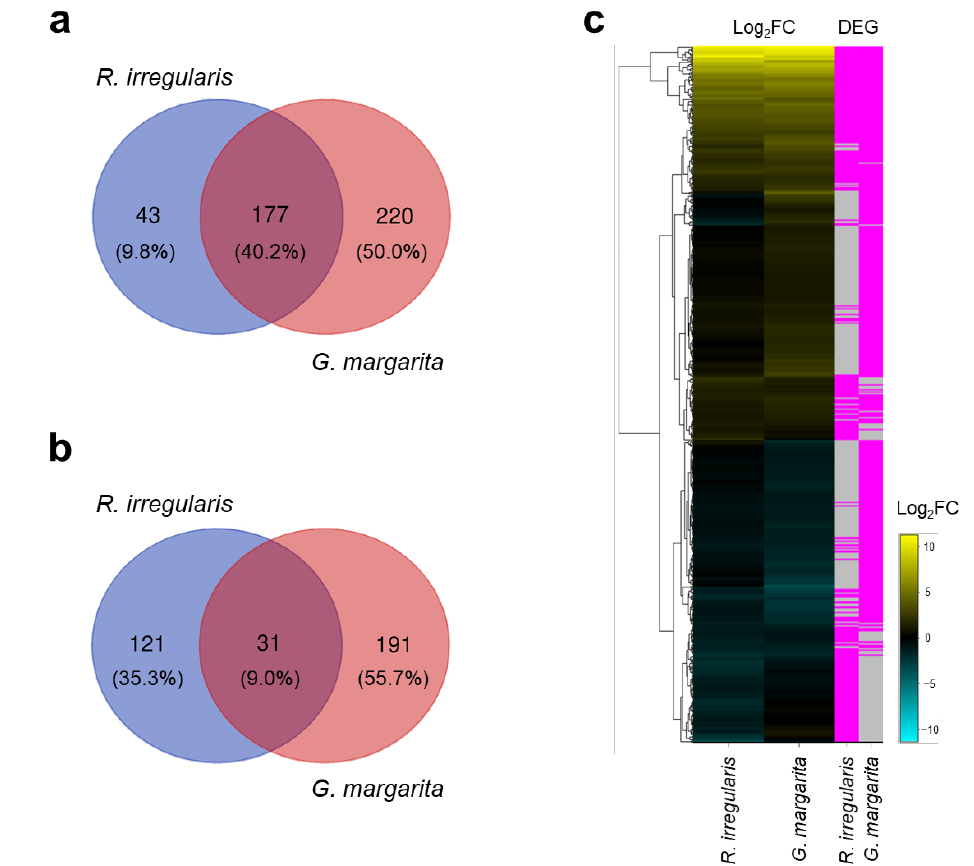
Figure 3. Differential expression analysis of tomato roots colonized by Rhizophagus irregularis or Gigaspora margarita . ( a , b ) Venn diagram of 440 AM-upregulated ( a ) and 343 AM-suppressed ( b ) genes compared with non-colonized roots at five weeks post-inoculation (wpi). Genes with |Log 2 Fold Change (FC)| > 1 and a false discovery rate (FDR) < 0.05 were considered differentially expressed genes (DEGs). ( c ) Hierarchical clustering of the total AM-responsive DEGs. The left-hand heatmap shows the Log 2 FC of genes expressed in colonized tomato roots relative to non-colonized roots. Blue indicates negative values; yellow, positive values; and black, zero change. The right-hand heatmap illustrates FDR values less than 0.05, with significant DEGs presented in pink. Detailed information about the DEGs can be found in Table